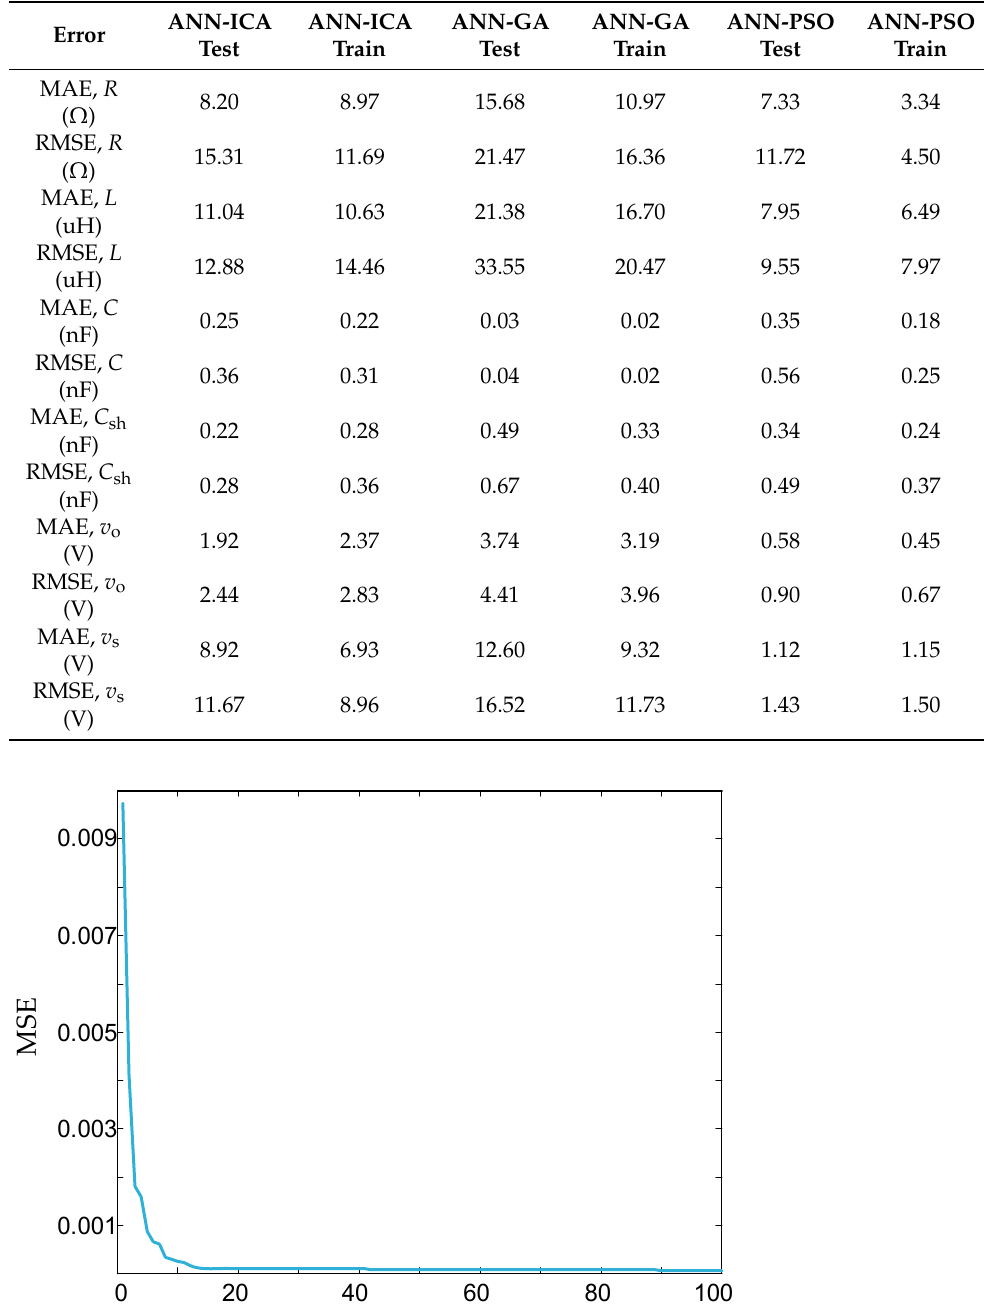
Table 3. Specifications of the PSO algorithm for initial modeling of the amplifier.